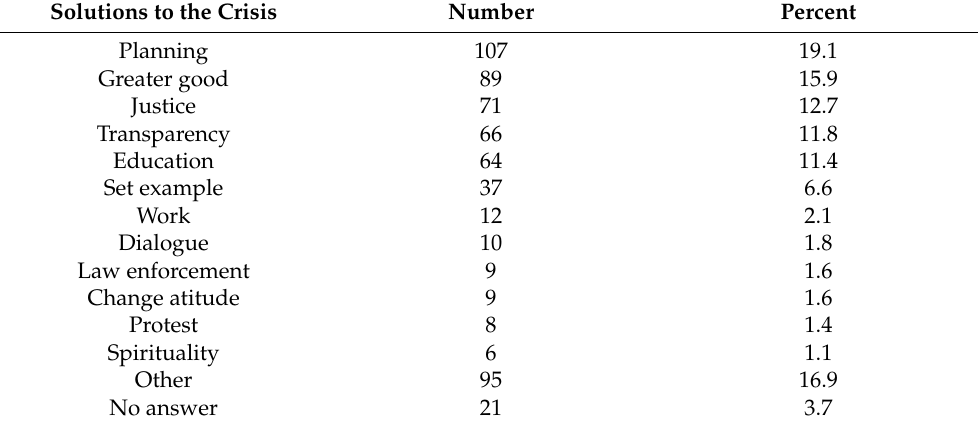
Table 8. Solutions to the